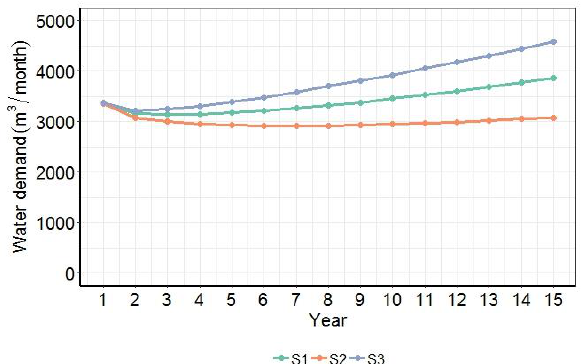
Figure 8. Simulated total water use for the three scenarios. While the aggregated water use clearly increases in scenarios S1 and S3, it is mitigated by the social trends and housing regulations—only exhibiting a slight increase at the end of the simulation.